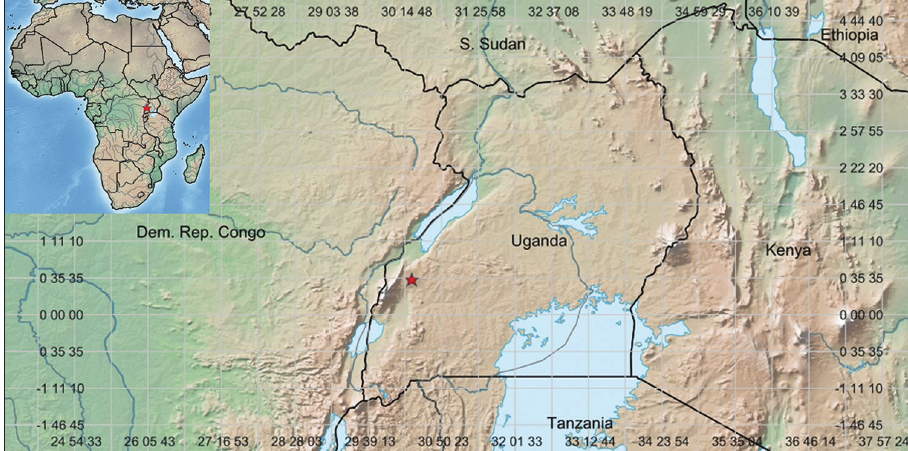
Figure 1. The sampling locality of Kibaleana apicospinosa sp. n. in southern Uganda.